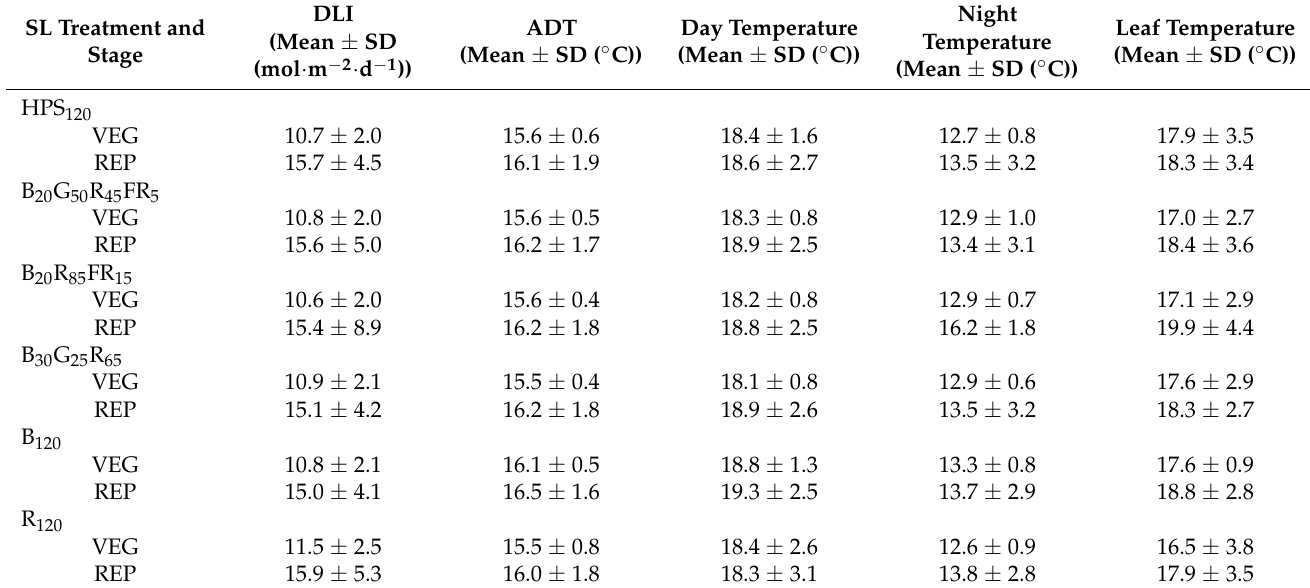
Table 1. Actual daily light integrals (DLIs) (mean ± SD (mol · m − 2 · d − 1 )), average daily temperatures (ADTs), mean day temperature, mean night temperature, and mean leaf temperature (mean ± SD ( ◦ C)) for each supplemental light (SL) treatment during the vegetative (VEG) and reproductive (REP) stages of replication 1. SL treatments consisted of either 460 W HPS fixtures (HPS 120 ; LR48877; P.L. Light Systems, Beamsville, ON, Canada), 631 W LED fixtures (B 20 G 50 R 45 FR 5 ; VYPR 2p; Fluence, Austin, TX, USA), 325 W LED fixtures (B 20 R 85 FR 15 ; LumiGrow Pro 325; LumiGrow, Emeryville, CA, USA), 600 W LED fixtures (B 30 G 25 R 65 ; LX601G, Heliospectra, Göteborg, Sweden), a combination of 72 W